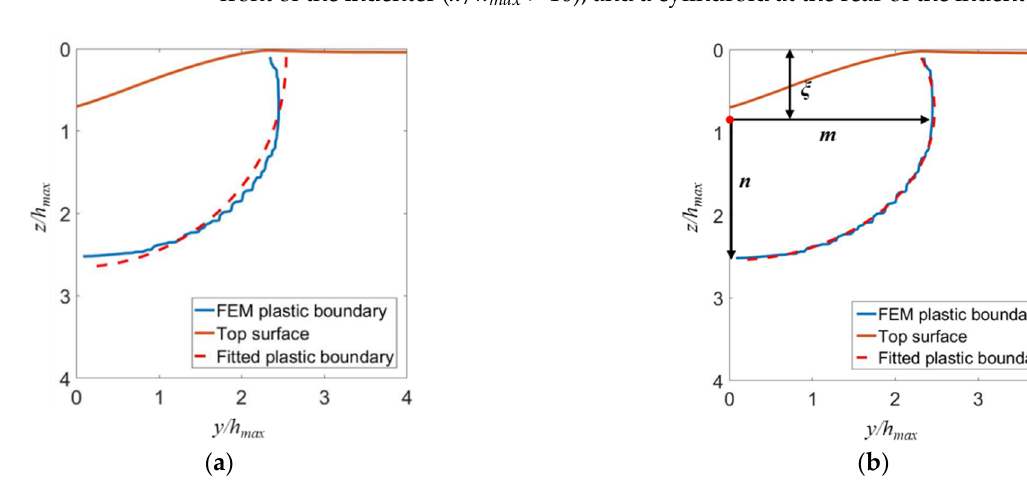
( a ) ( b ) Figure 14. The contours of von Mises equivalent plastic strain in the xz -cross-section ( a ) at the fully loaded and ( b ) fully unloaded states. As shown in Figure 13b, the shape of the elastic–plastic boundary is characterized by the length m of the semi-major axis, the length n of the semi-minor axis, and the depth ξ of the elastic–plastic boundary center. The semi-major and semi-minor axes are along the lateral and vertical directions, respectively. These parameters can be determined by fitting the elastic–plastic boundary by the following formula: 2